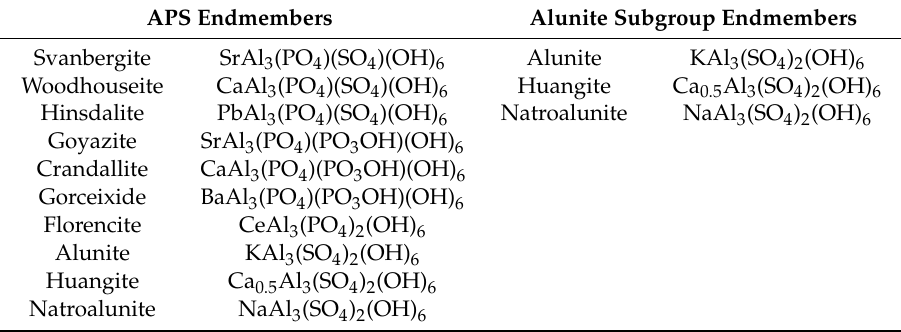
Table 1. Endmember compositions of aluminum-phosphate-sulfates (APS) and alunite. APS Endmembers Alunite Subgroup Endmembers